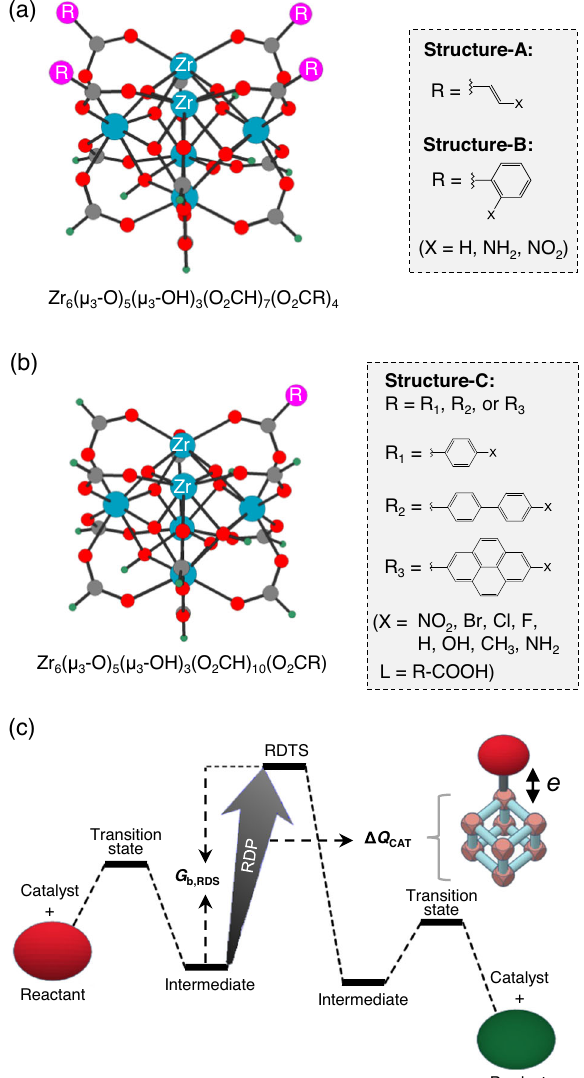
Fig. 2 Structural models of UiO-66 and the de fi nition of quantities relevant to the catalytic kinetics. a Structure-A and B. b Structure-C. c Diagram showing de fi nitions of rate-determining transition state (RDTS), rate-determining process (RDP), free energy barrier for rate-determining step ( G b,RDS ), and change of catalyst charge in RDP ( Δ Q CAT ). In a , b , the coordinatively unsaturated zirconium atoms are labeled, and the color setting for atoms is: Zr, gray blue; H, sea green; O, red; C, gray; R,